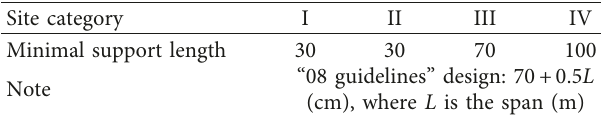
Table 7: Minimum seating length provided by cap girder (unit: